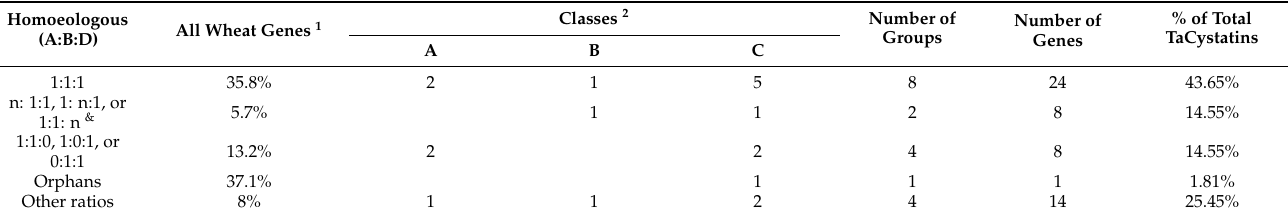
Table 3. Groups of homeologous cystatin genes in bread